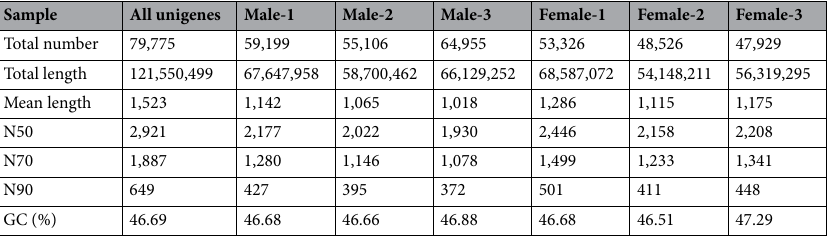
Table 2. Statistics for the assembled unigenes.